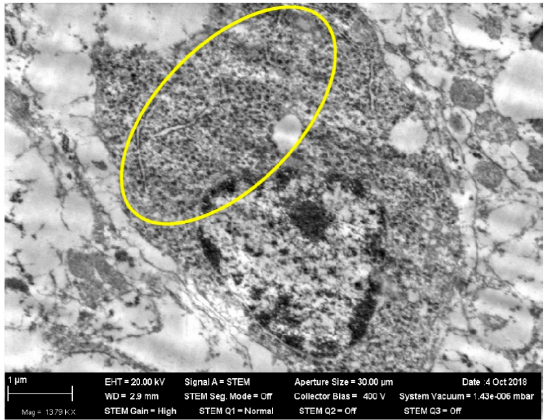
Figure 1. Nanoparticles in the body of a neuron in an olfactory bulb of rat brain after 3 months of inhalation exposure to NIO-NPs at a concentration of 0.23 mg / m 3 . STEM; magnification: 13,790 × . (See within the yellow oval.)